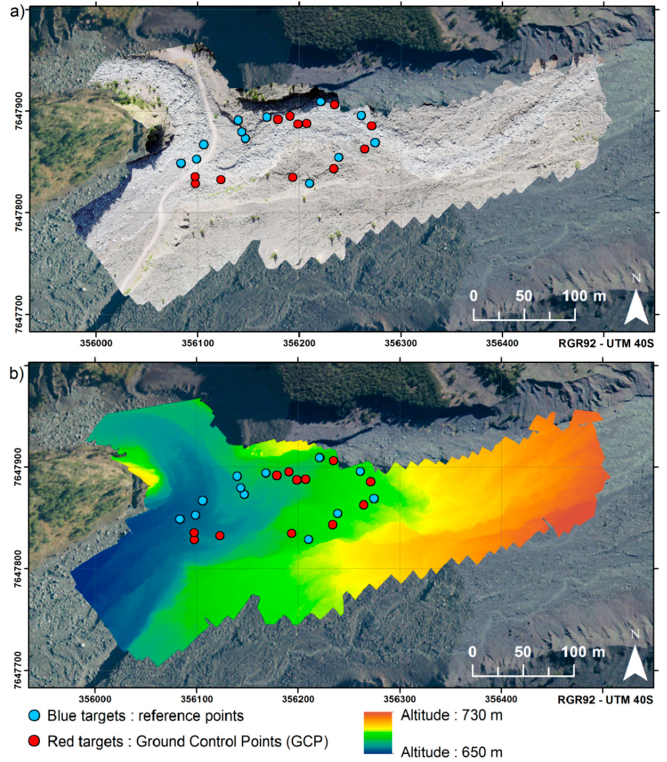
Figure 6. Orthophotograph ( a ) and Digital Surface Model ( b ) reconstructed by SfM photogrammetry (by PhotoScan is this example) from a set of 109 manually selected UAV images. In this example, 12 GCP (depicted by red spots) have been used.